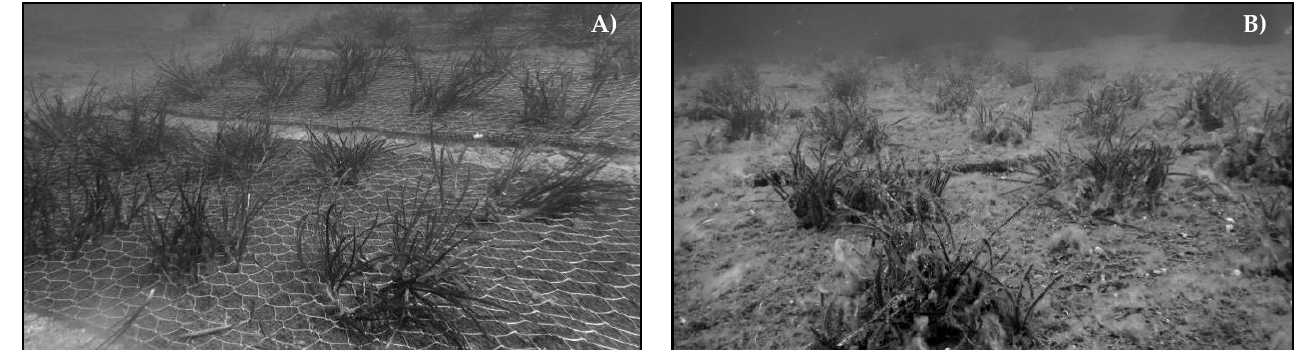
Figure 8. Transplants at Elba Island after the set-up ( A ) and after one year ( B ).